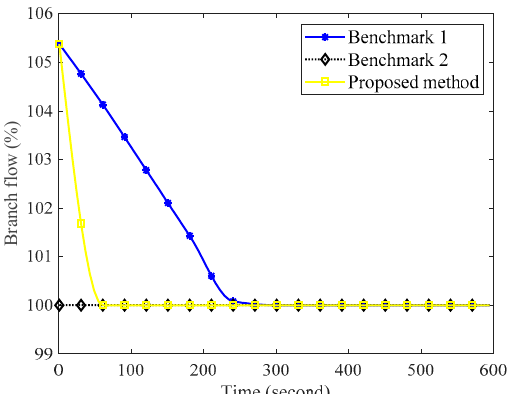
Figure 3. The branch flow between buses 6 and 11 under the contingency of the branch between buses 13 and 14.